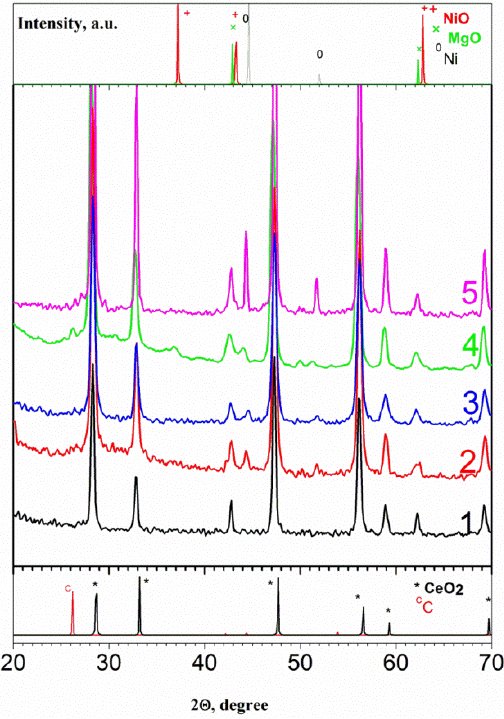
Figure 8. X-ray diffraction patterns of the catalysts after the CSMR reaction at 750 °C. 1—Ni/CeMg- C-S-O; 2—Ni/CeMg-A-S-V; 3—Ni/CeMg-A-S-O; 4—Ni-Pd/CeMg-A-S-V; 5—Ni/CeMg-A-P-O.